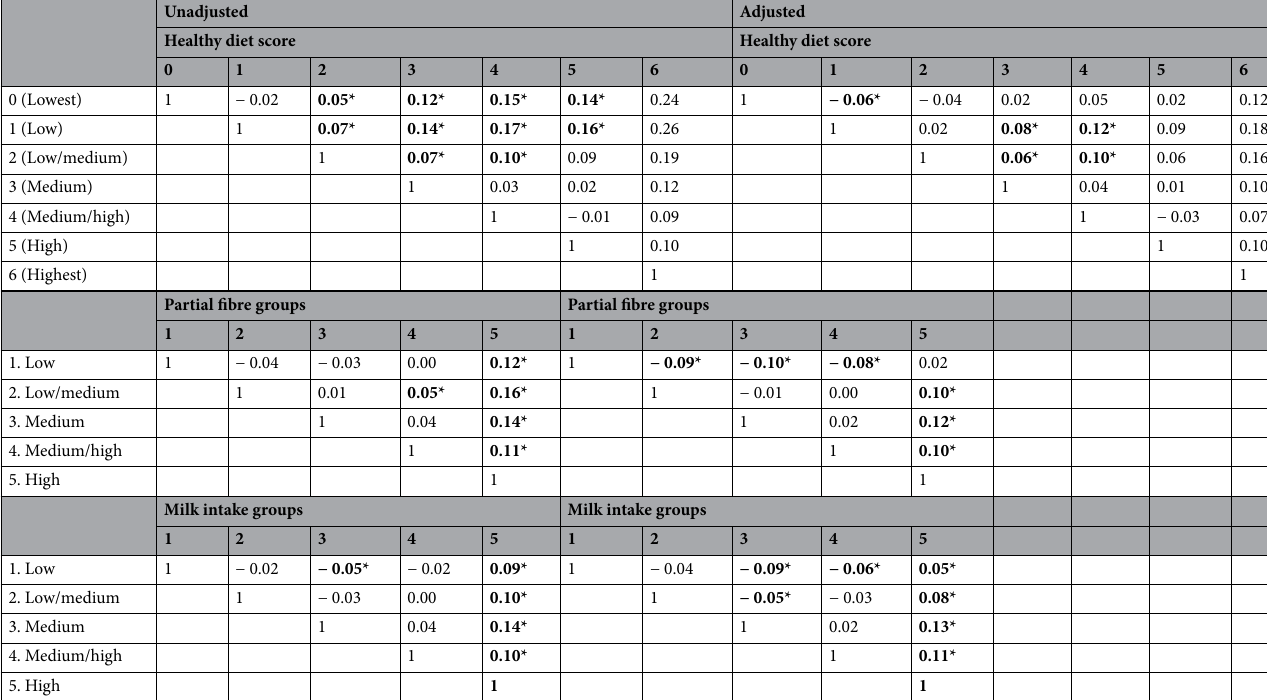
Unadjusted Adjusted Healthy diet score Healthy diet